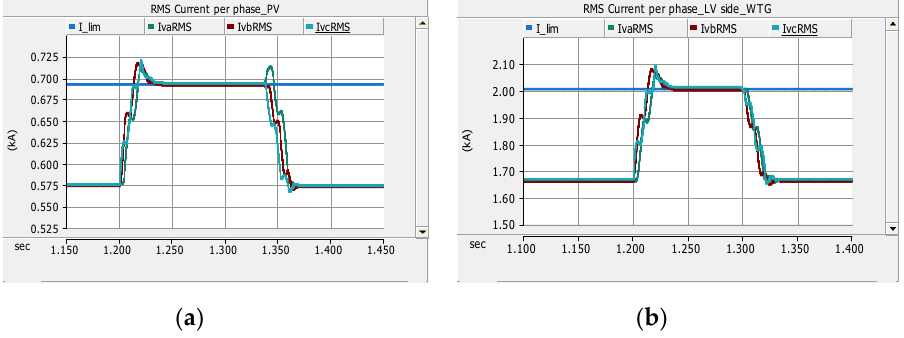
Figure 20. RMS current magnitude per phase of DGs before, during and after fault F2 in the islanded mode (CB7 transfer trip): ( a ) LV side of the PV system and ( b ) LV side of the WTG.